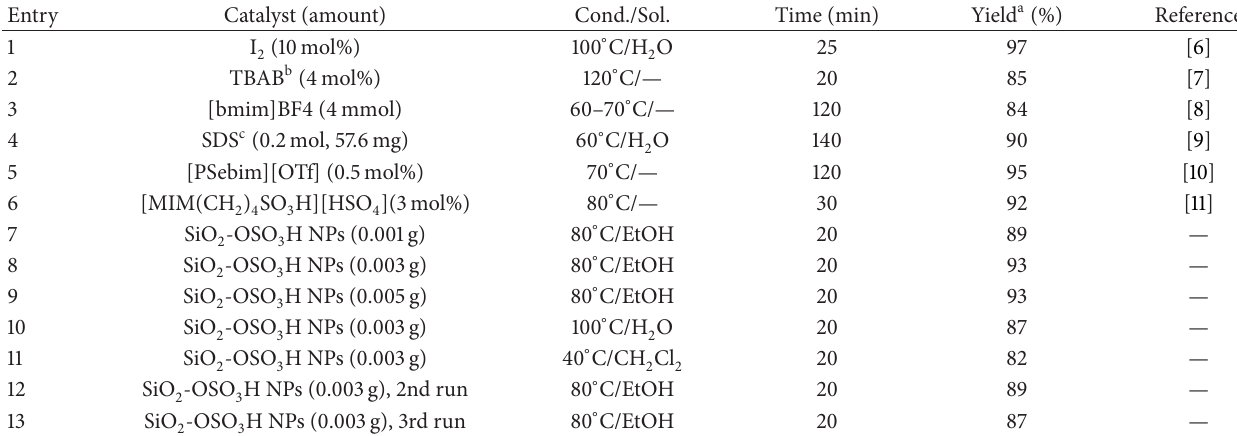
Table 1: Synthesis of 4a under various conditions.